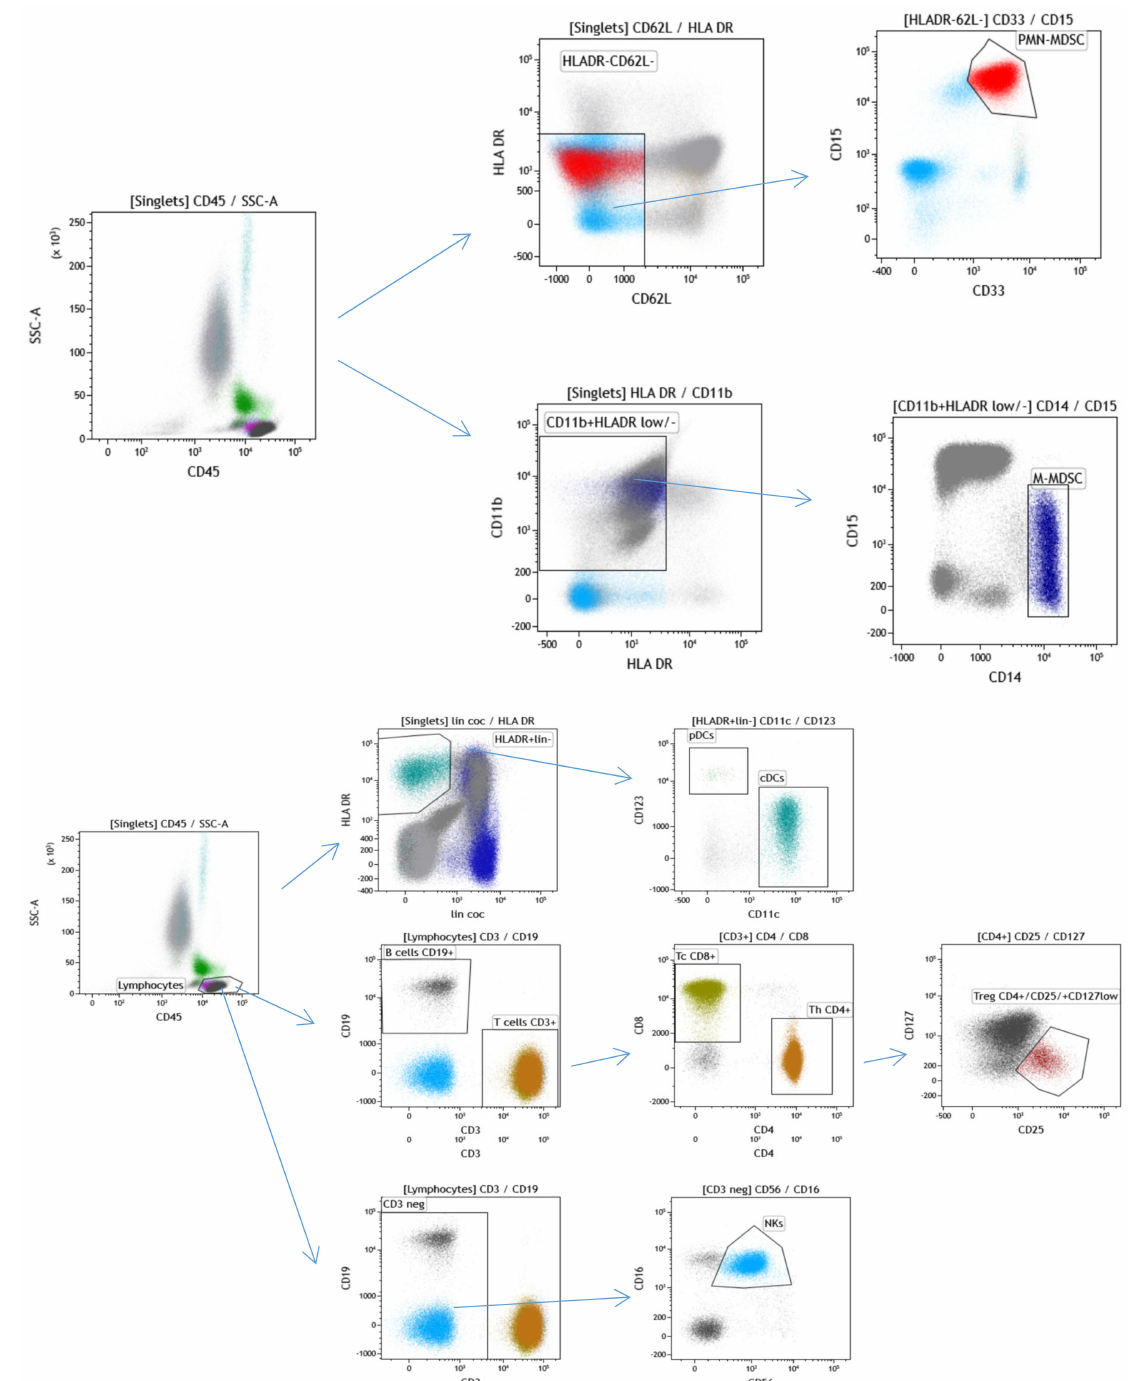
Figure 2. Flow cytometry gating strategy used for immunophenotyping selected leukocyte subpopulations in GCT patients. The cells were first gated by forward scatter (FSC) and side scatter (SSC) following doublet exclusion using forward scatter area (FSC-A)/forward scatter height (FSC-H) (not shown). CD15 + CD33 + CD62L-HLADR-/low (PMN-MDSCs) and CD14 + CD11b + HLADR-/low (M-MDSCs) are shown on the top. Dendritic cells were identified by CD45 + HLADR + lin- and subsequently distinguished by CD123 + CD11c-(pDC) and CD11c + (mDC) expression, as shown in the middle of the figure. Total lymphocytes were gated on a CD45/SSC and then gated on CD19+ (B cells) vs. CD3+ (T cells), CD4+ (Th cells) vs. CD8+ (Tc cells) and CD56 + CD16 + CD3-(NK cells). CD4+ cells were used for the identification of CD25+ CD127-/low